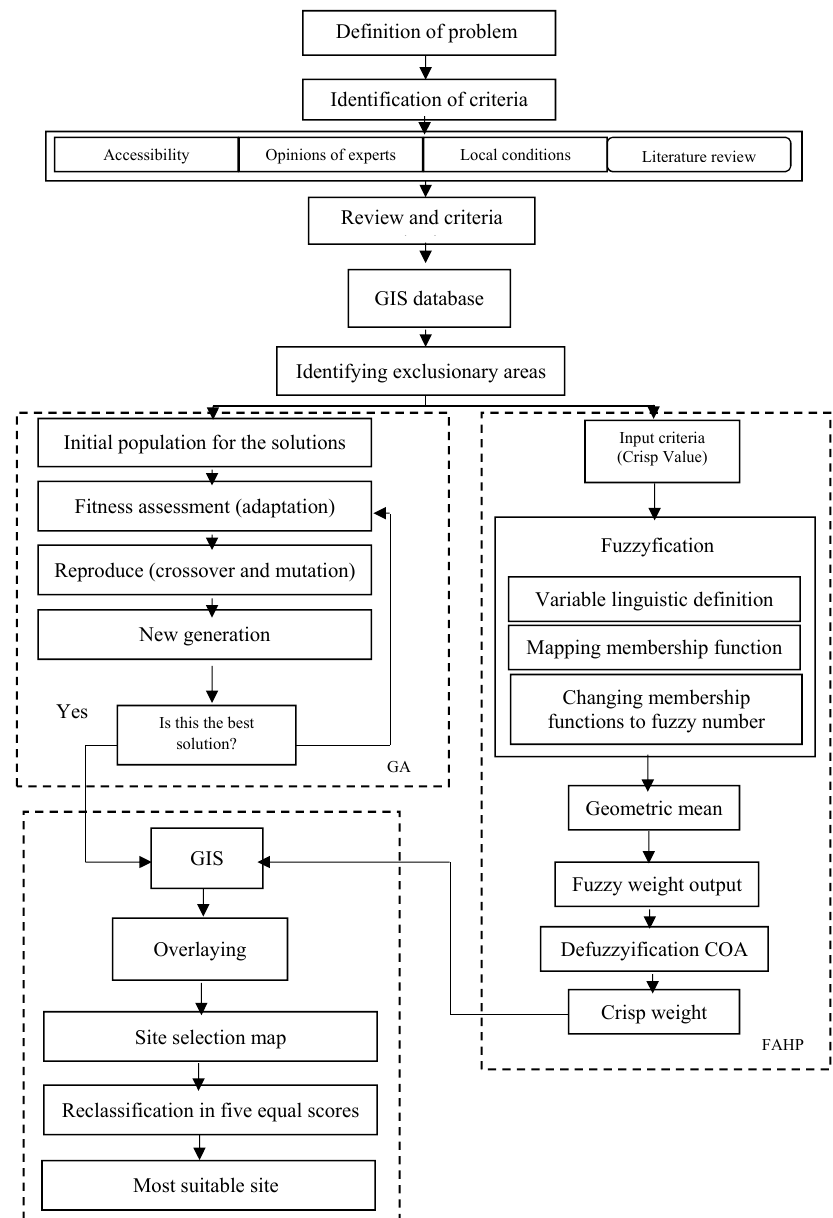
Fig. 2: Integrated approach of genetic algorithm and fuzzy for site selection in geographic information system